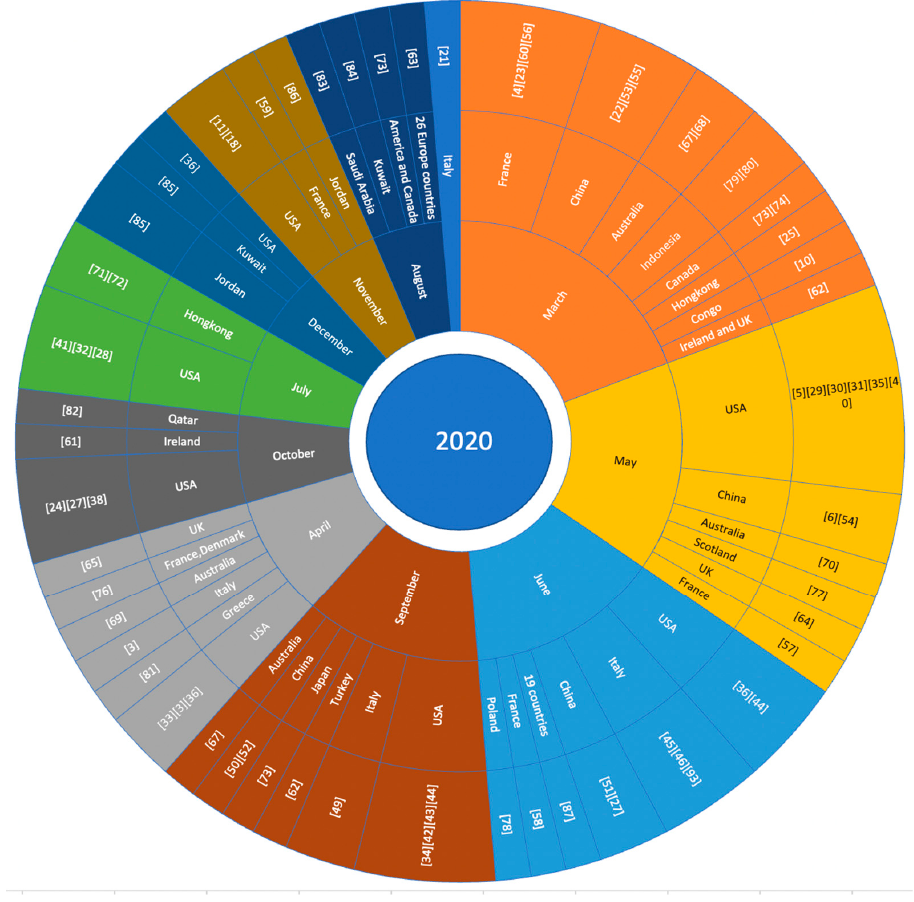
Figure 2. Studies conducted in 2020.